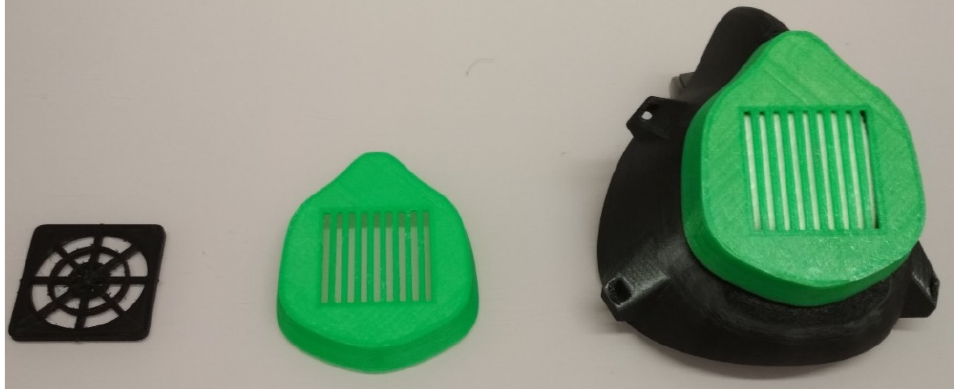
Figure 11. Complete respirator and its separate parts.